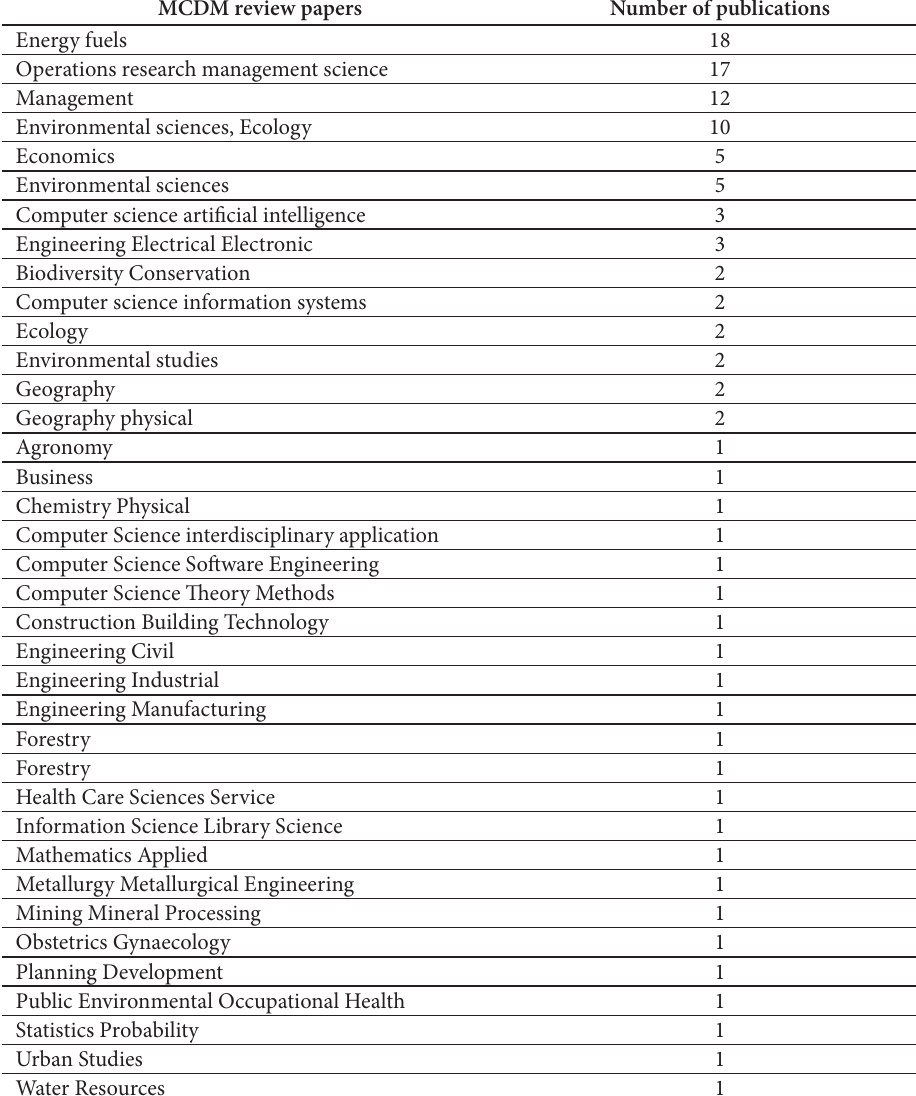
Table. 1. Number of publications by research area MCDM review papers (from database ISI Web of Science